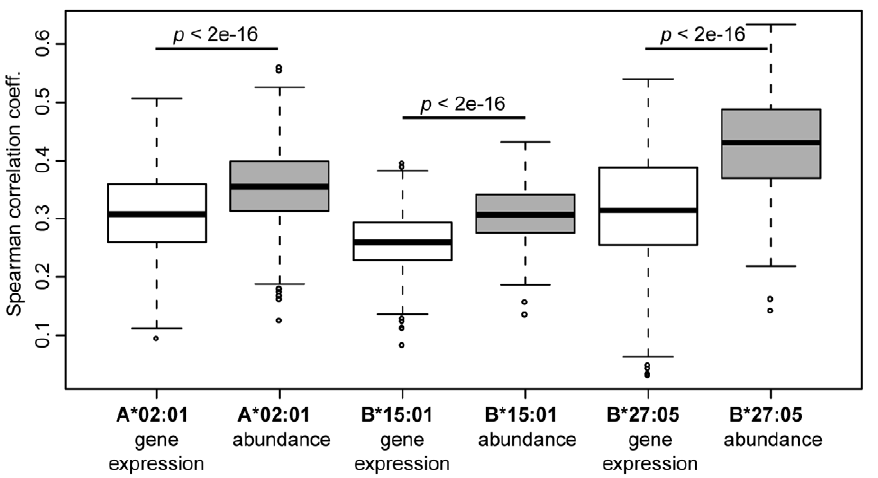
Figure 5. Protein abundance carries more information for the prediction of sampling probability than gene expression level. Boxplots of the Spearman correlation coefficients resulting from one hundred 5 6 cross-validation runs for regression models that either include gene expression data or protein abundance data.